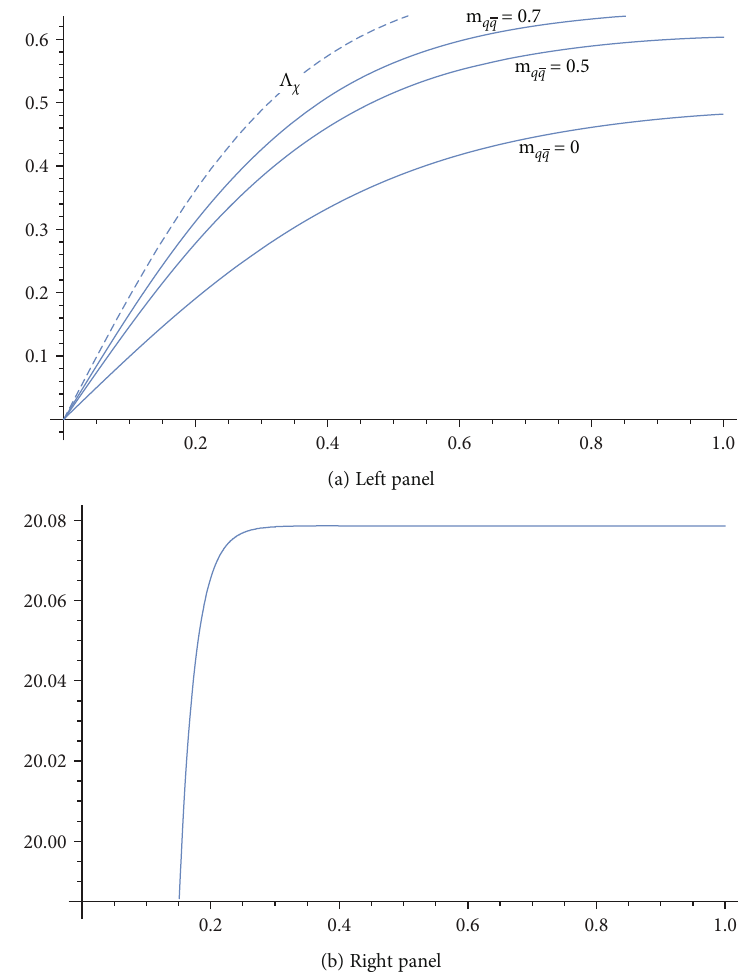
ð r , m Þ , against ( r , m c q (cid:1) q